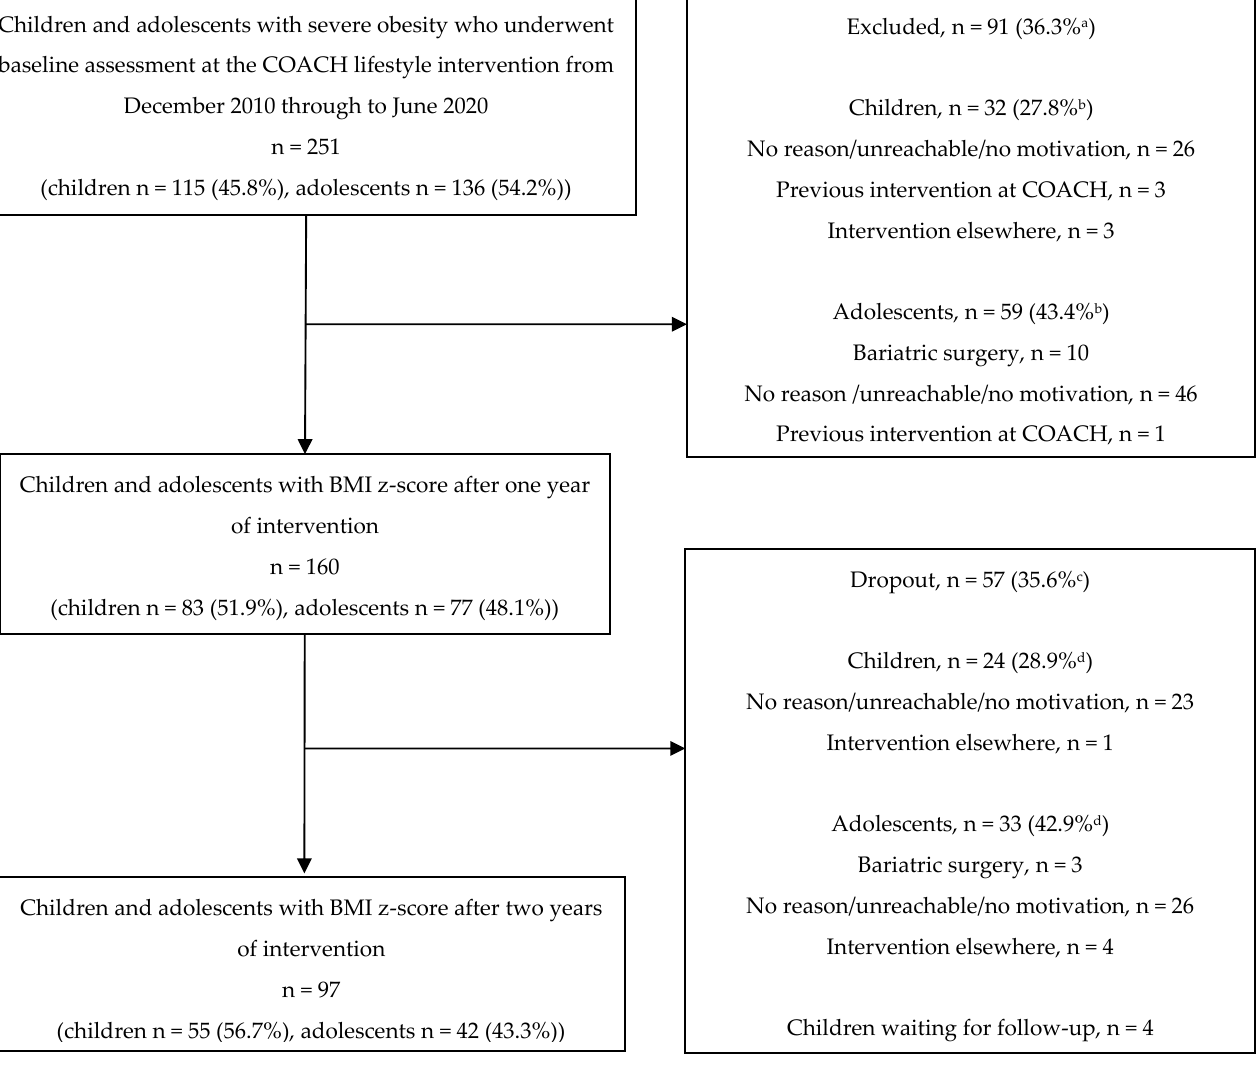
Figure 1. Flow diagram of the exclusion and dropout of children and adolescents with severe obesity from the COACH lifestyle intervention. a Number of excluded participants/number of participants with a baseline assessment from 2010 through 2020. b Number of children or adolescents who were excluded/number of children or adolescents with a baseline assessment from 2010 through 2020. c Dropout of the COACH lifestyle after one year of intervention/number of participants with a BMI z- score after one year of intervention. d Number of children or adolescents who dropped out of the a BMI-z-score after one year of intervention.